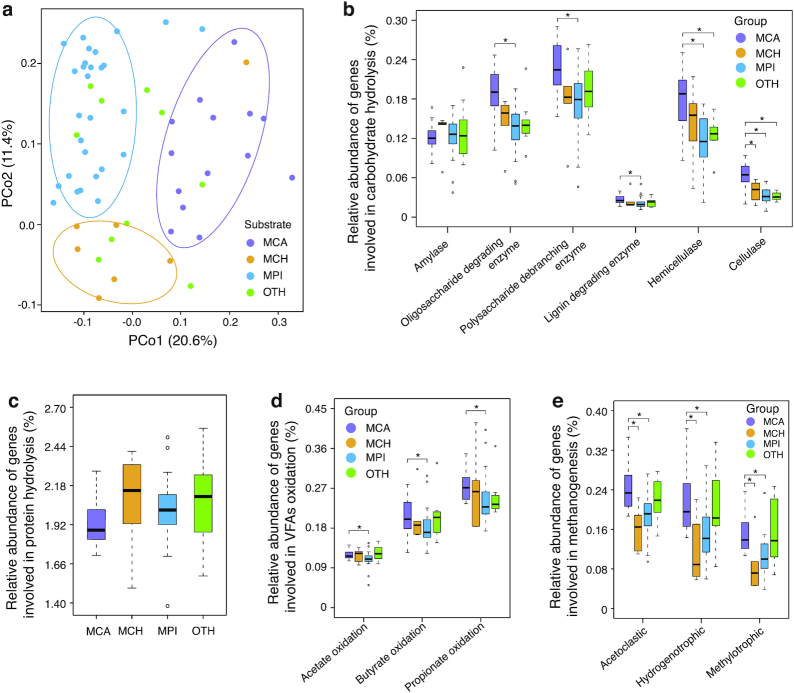
Comparisons of taxonomic and functional profiles among different biogas plants (BGPs). a, Principal coordinate analysis (PCoA) based on Bray-Curtis dissimilarity at the species level. The digestate samples were separated into 3 clusters (MCA, MCH, and MPI). MCA: cattle manure BGPs; MCH: chicken manure BGPs; MPI: pig manure BGPs; OTH: BGPs with other substrates. b, Relative abundance of genes involved in the hydrolysis of starch, oligosaccharide, polysaccharide, and lignocellulose (lignin, hemicellulose, and cellulose). c, Relative abundance of genes involved in protein hydrolysis. d, Relative abundance of genes involved in acetate, propionate, and butyrate oxidation. e, Relative abundance of genes involved in methanogenesis. Box plots show the median ± interquartile range (IQR) and 1.5 IQR ranges (whiskers), with outliers denoted by circles. Wilcoxon rank-sum test among different groups was performed. *P < 0.05.